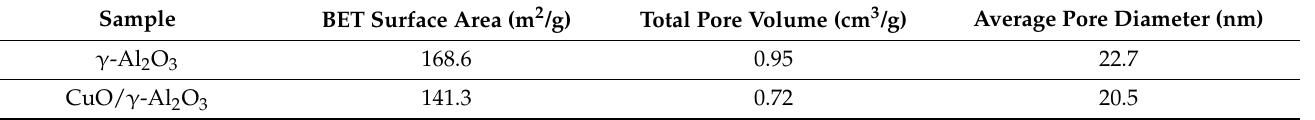
Table 2. Physicochemical properties of the CuO/ γ -Al 2 O 3 catalyst and γ -Al 2 O 3 powder.